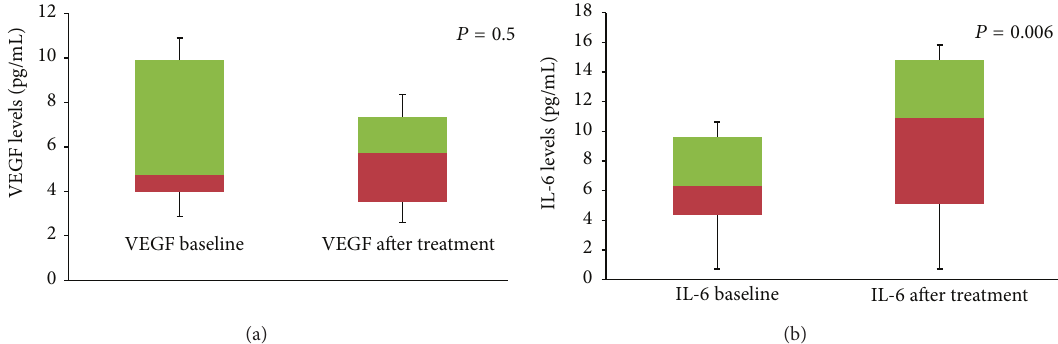
Figure 3: Box plot diagram showing the change in mean aqueous VEGF levels (a) and change in mean aqueous IL-6 levels (b) in patients in group 2. The error bar represents standard